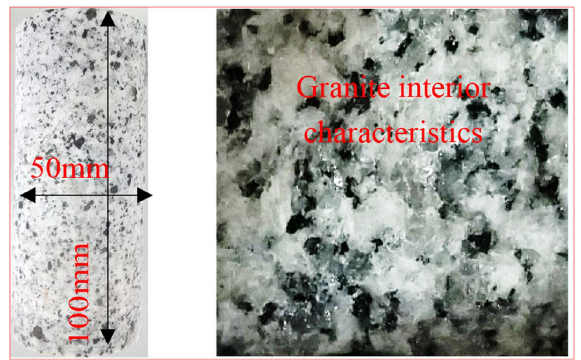
Figure 16. Interior characteristic of the granite studied in this work.